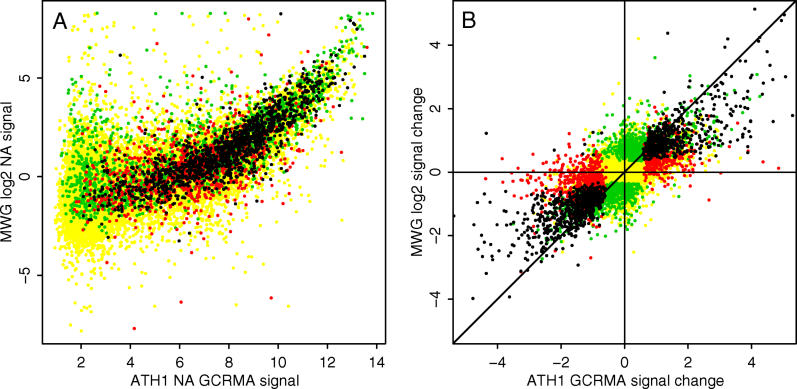
Comparison of log2 Signal and Signal Changes between the ATH1 and MWG ArraysShown here is a comparison of log2 signal for nonacclimated plants (A) and log2 signal change during cold acclimation (B), between the ATH1 and MWG arrays. Data are for the 20,159 genes that are represented by probes on both the ATH1 and the MWG arrays. Genes are colored on the basis of their detection as significantly (FDR p < 0.05) differentially expressed in response to 14 d cold acclimation using the two-array datasets. Black, both datasets; green, MWG; red, ATH1; yellow, neither.